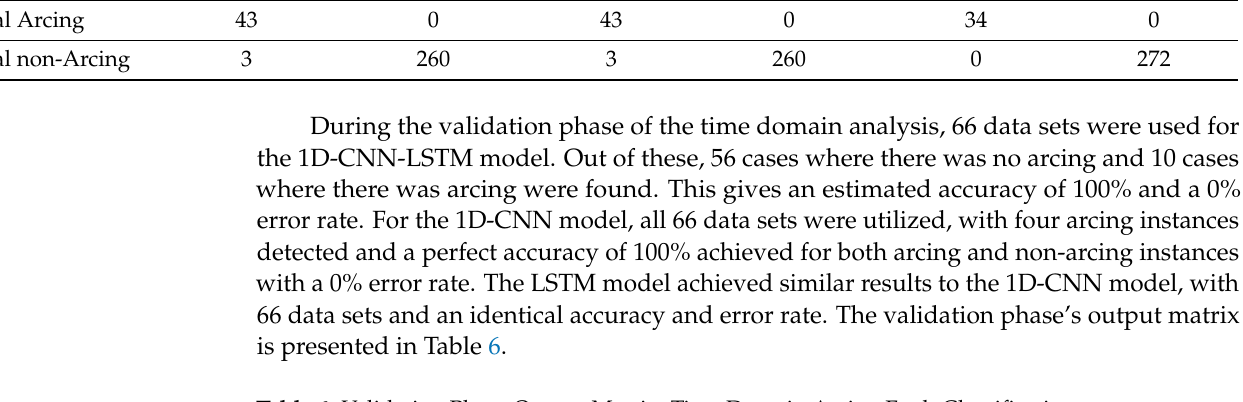
Table 6. Validation Phase Output Matrix: Time Domain Arcing Fault Classification.